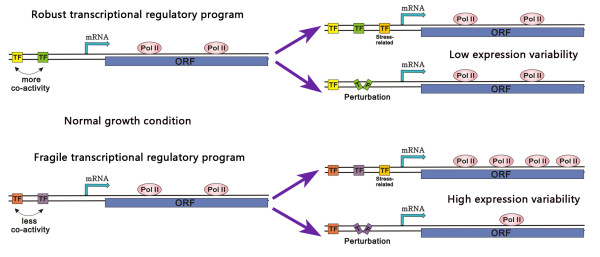
A model for robust and fragile transcriptional regulatory programs. Pol II density over the ORF indicates expression level. In the robust transcriptional regulatory program, cooperative TFs work together in an activity-redundant fashion under normal growth condition (the left top panel). Accordingly, the expression level of the robust gene is not affected by stress-related TF binding or TF perturbation (knockout, sequence divergence, activity changes) (the right top two panels). While in the fragile transcriptional regulatory program, cooperative TFs work in an activity-independent fashion under normal growth condition (the left bottom panel). This leads to the expression level of the fragile gene sensitive to stress-related TF binding and TF perturbation (the right bottom two panels).